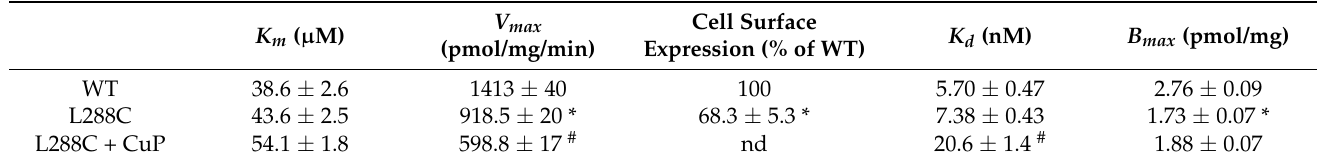
Table 1. Kinetic parameters of [ 3 H]glycine uptake and [ 3 H]CHIBA-3007 binding with or without CuP